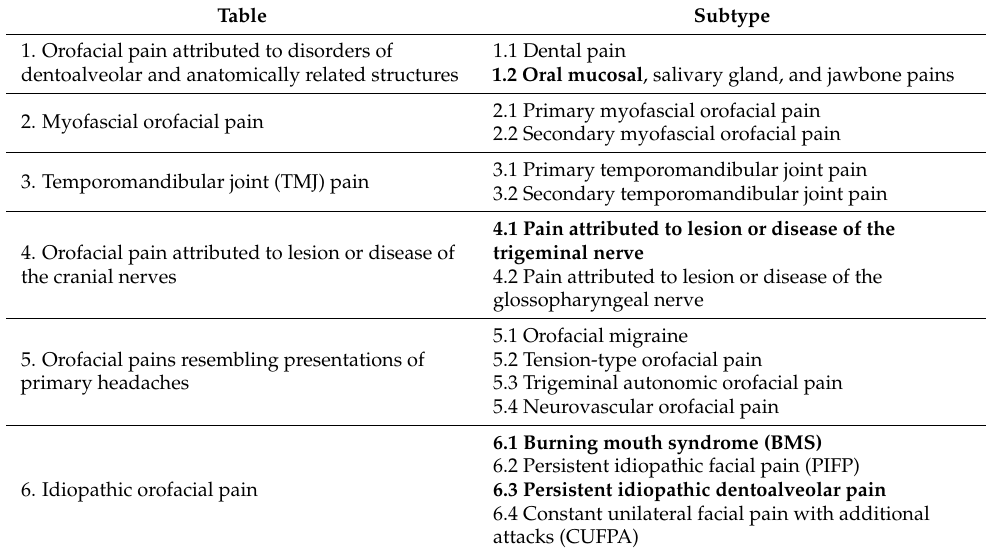
Table 1. Classification overview of the International Classification of Orofacial Pain (ICOP) *. Table